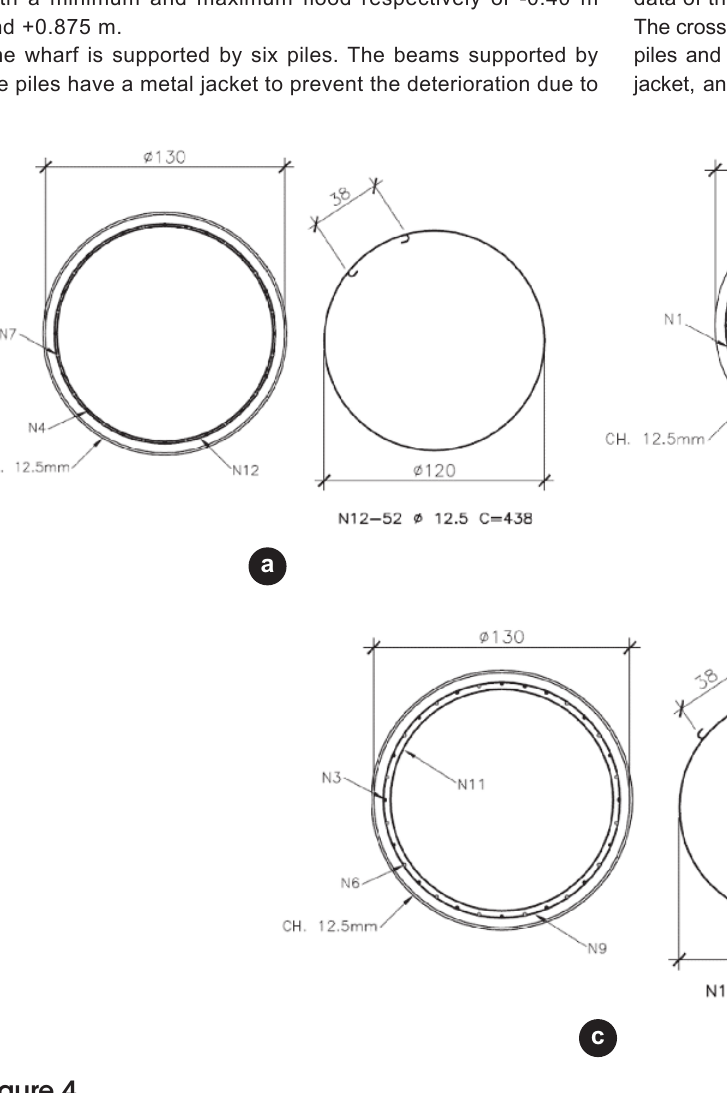
Cross section at top (a), middle (b) and bottom (c) of the piles (the dimension is in mm) (C: reinforcing length in